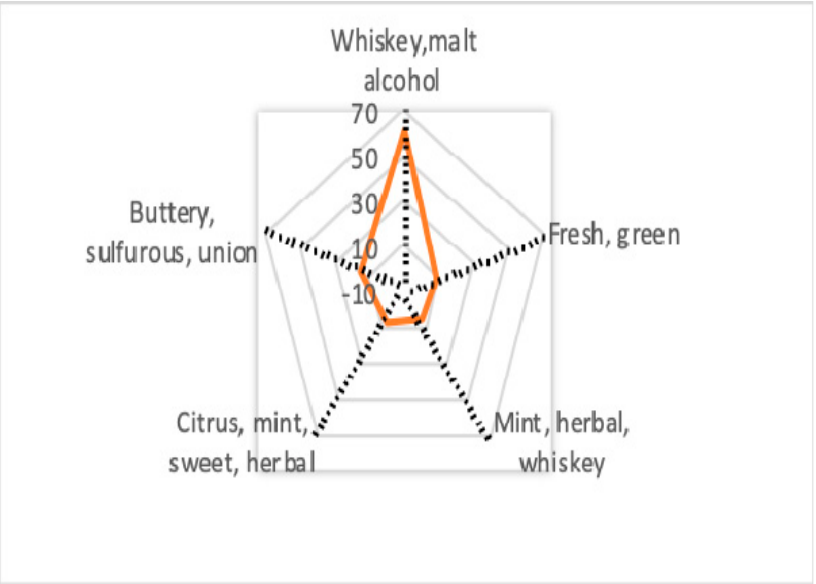
Figure 1. Aroma profile of spent malt rootlets by main compounds classes identified during GC-MS analysis.